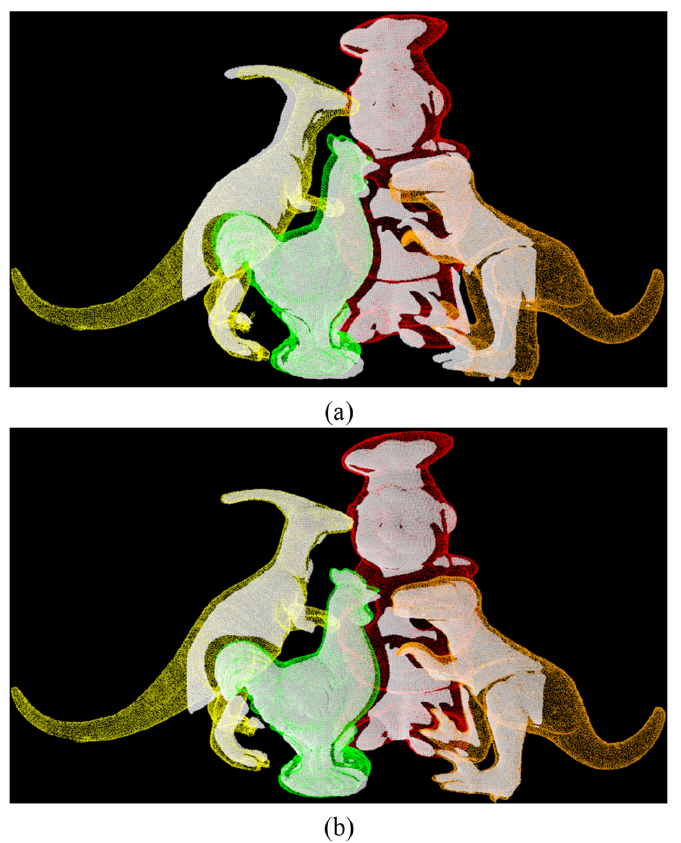
Figure 14. ( a ) is the result of using our proposed Cur-PPF algorithm to recognize different objects in the same scene, and ( b ) is the registration result of Figure ( a ) after optimization by the traditional ICP algorithm. Table 5. The matching rate of Cur-PPF and Cur-PPF+ICP algorithms on Laser Scanner.